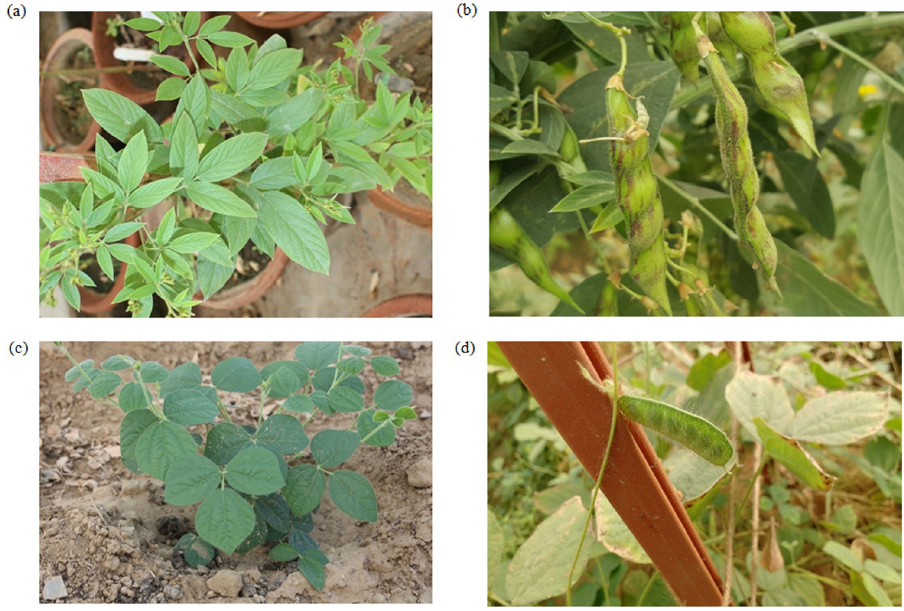
Fig 1. (a—b) morphology of cultivated pigeonpea ( C . cajan ) plant and their pods respectively. (c—d) morphology of the wild relative of pigeonpea ( C . platycarpus ) plant and their pods